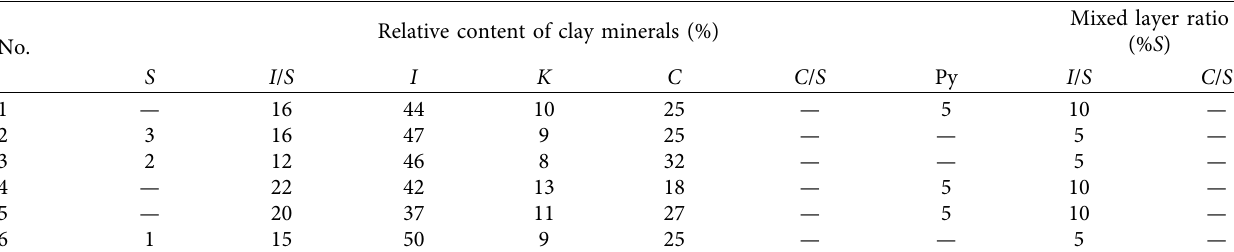
Table 3: Relative content of different minerals in the clay mass.